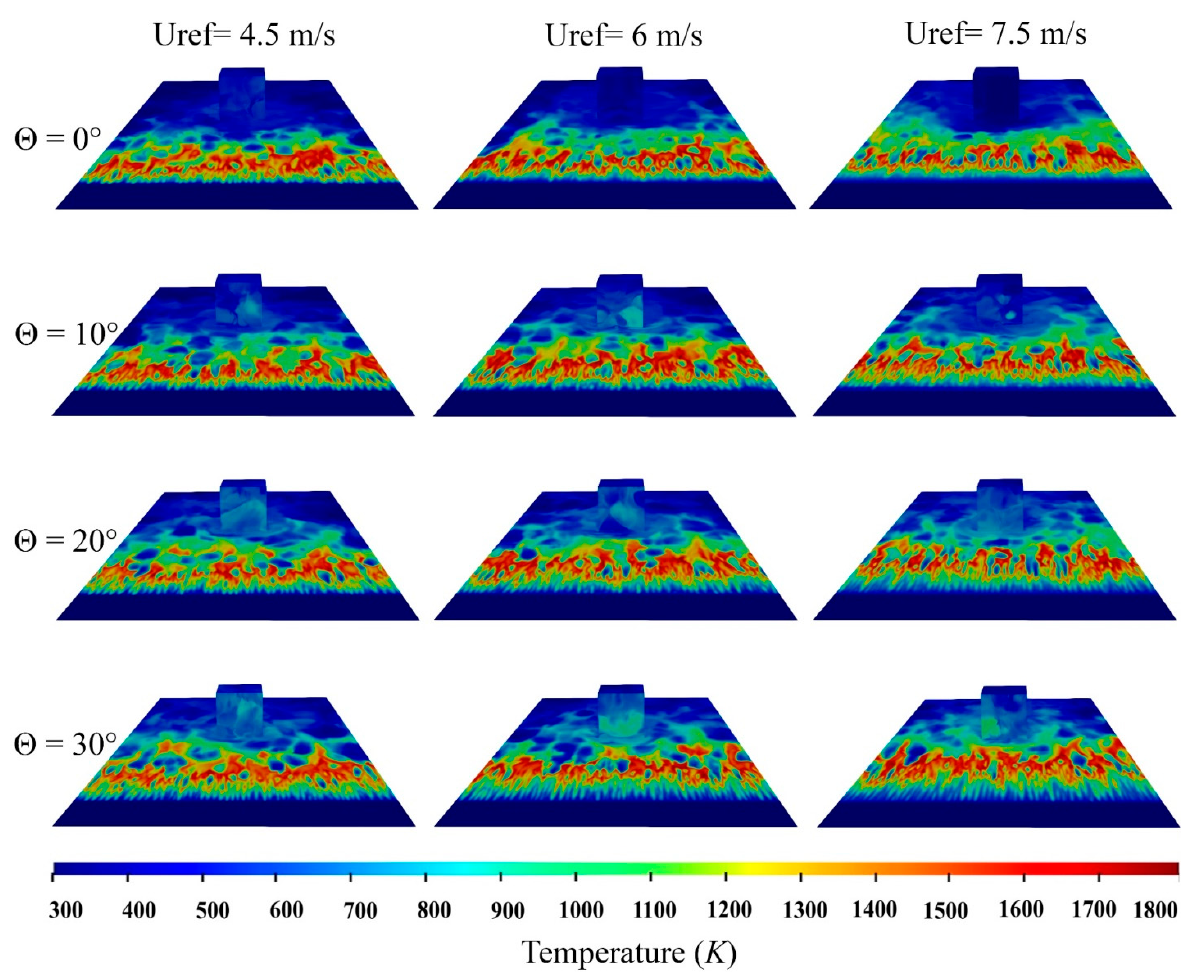
Figure 9. Temperature distribution on the ground in U ref = 4.5, 6, and 7.5 m/s and terrain slope 0°, 10°, 20°, and 30°. Figure 10 indicates the integrated temperature on the ground and at the domain for three different reference velocities of 4.5, 6, and 7.5 m/s and terrain slopes 0, 10, 20, and 30°. The integrated temperature of the ground is defined as the mean temperature of the whole ground surface. Due to the fact that each point of the surface has a different tem- perature, the integrated temperature is calculated in these simulations. As seen, the three